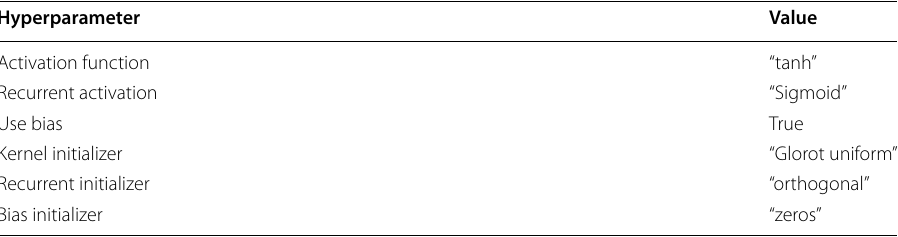
Table 7 Hyperparameters for the LSTM layer Hyperparameter Value Activation